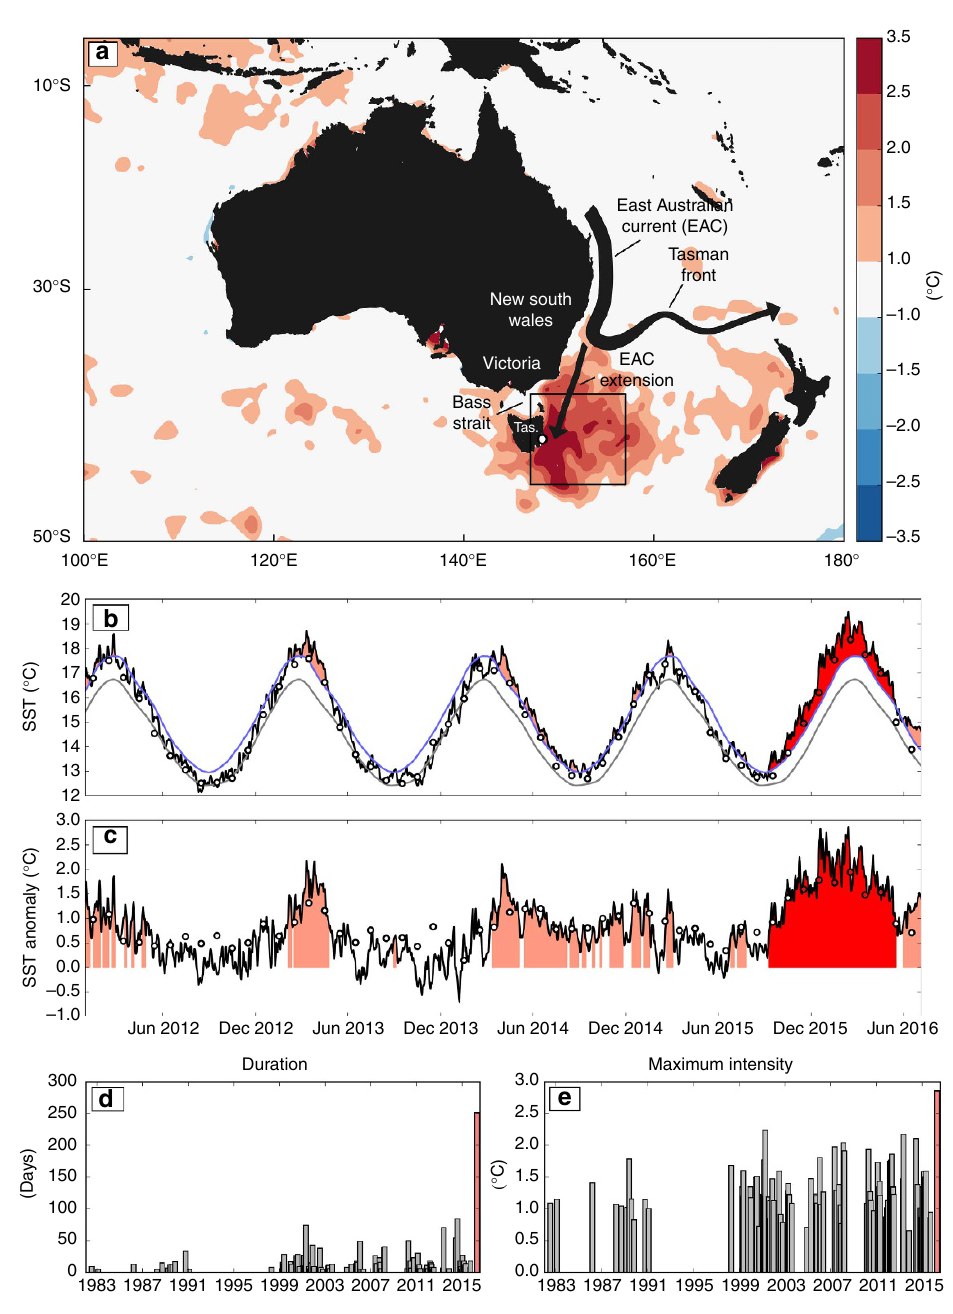
Figure 1 | The 2015/16 MHW off southeast Australia. ( a ) The mean 2015/16 austral summer (December to February) mean SSTanomalies from NOAA OI SST, the box used to define the southeast Austraila (SEAus) region (black lines) and the location of the Maria Island Time Series (open circle). Anomalies are relative to the 1982–2005 climatology. Also shown are time series of ( b ) SSTand ( c ) SSTanomalies averaged over the SEAus region since 2012 from NOAA OI SST (black lines) and HadISST (circles). The red-filled circles in b , c indicate which months during the event were among the top ten on record since 1880. The grey and blue lines in b indicate the climatological mean and 90th percentile threshold, respectively, calculated from NOAA OI SST. The pink-shaded regions in b , c indicate all MHWs detected using the Hobday et al. 2 definition and the red-shaded region is the 2015/16 event. The ( d ) duration and ( e ) maximum intensity are shown for this event as red bars along with values for all previous events on record back to